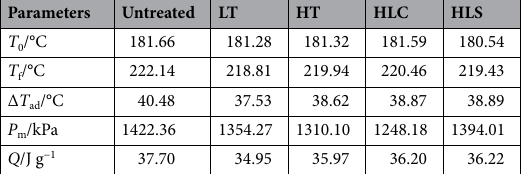
Table 5. ARC measured adiabatic thermal decomposition parameters.